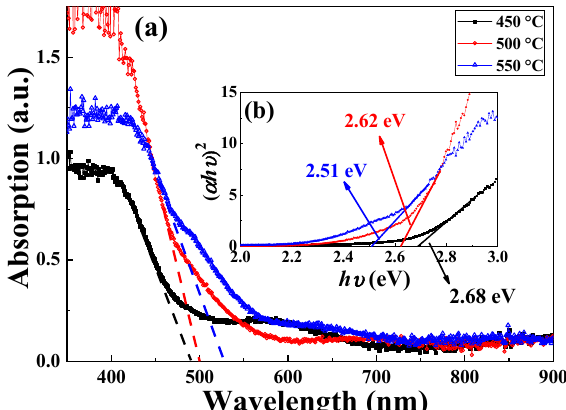
Figure6. ( a )Theultraviolet–visibleabsorptionspectraofBFOthinfilmsannealedatvarioustemperature. Figure 6. ( a ) The ultraviolet–visible absorption spectra of BFO thin films annealed at various ( b ) Plots of ( α h ν ) 2 and h ν for the samples. Materials 2019 , 12 , x FOR PEER REVIEW temperature. ( b ) Plots of ( α h ν ) 2 and h ν for the samples.